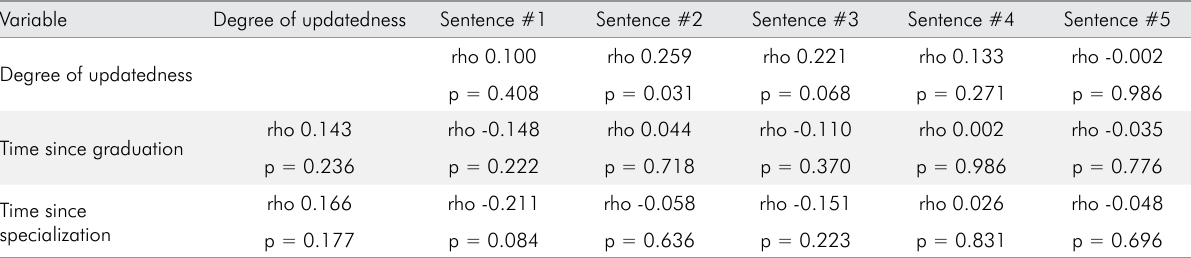
Table 3. Correlation among degree of updatedness in MID, agreement with the sentences, and time since graduation of the participants.